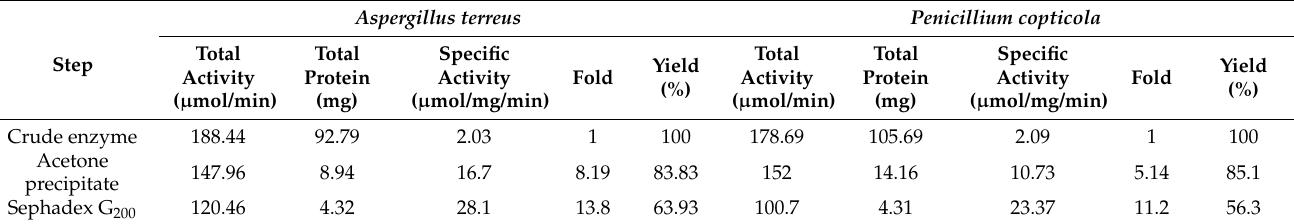
Table 4. Overall purification profile of TYR from Aspergillus terreus and Penicillium